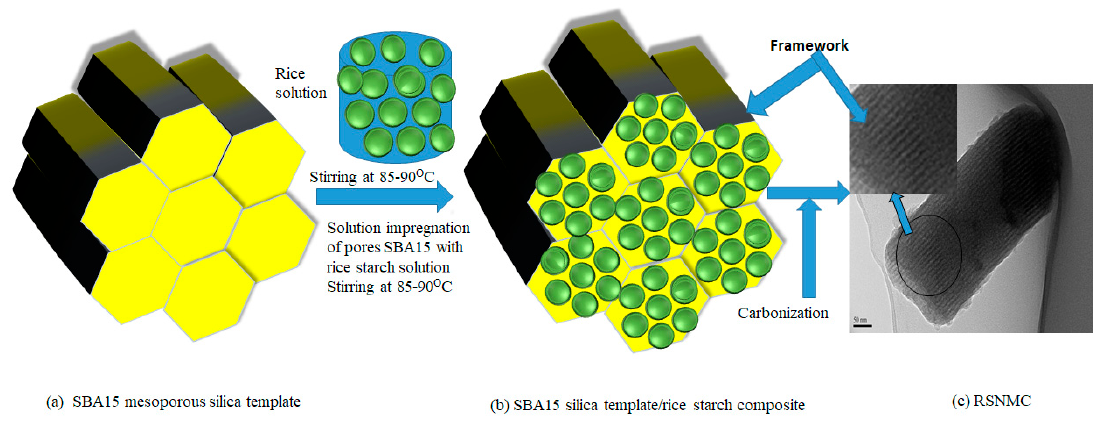
Figure 1. Preparation of nano/mesoporous carbon nanomaterials from rice starch.